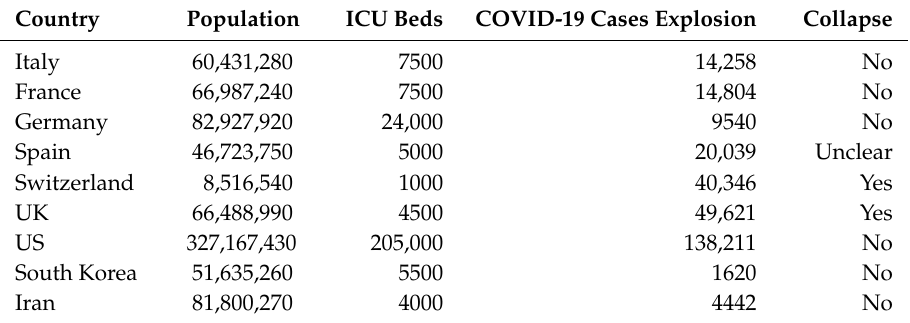
Table 2. Population, intensive care unit (ICU) beds, forecast of newly incoming COVID-19 cases between 12 April 2020 and 26 April 2020, and if there is a collapse in the healthcare system of Italy, France, Germany, Spain, Switzerland, United Kingdom (UK), United States (US), South Korea, and Iran.